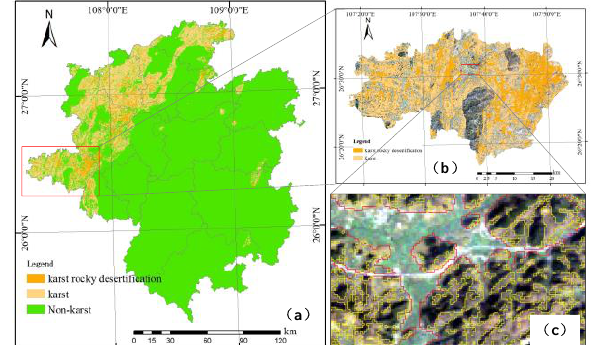
Figure 4. Karst area and karst rocky distribution area of Qiandongnan Miao and Dong Autonomous Prefecture in Guizhou Province, China in 2010; with the human-computer interaction interpretation above, a thematic map of karst of study area has depicted in Fig. 4(a). A thematic map of karst area and karst rocky distribution area of Majiang County has depicted in Fig. 4(b). A zoom-in window is enlarged in Fig. 4(c); with the yellow area in the figure is the karst rocky distribution patch, and the red area in the figure is the karst